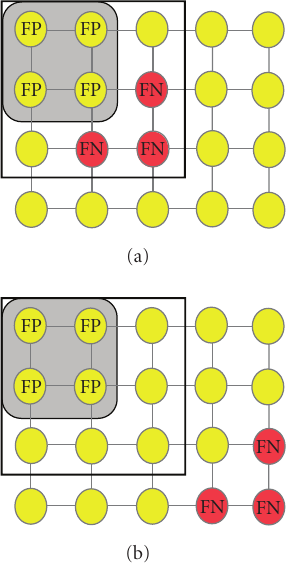
Figure 4: Schematic representation of an intracranial EEG grid placed on the surface of the brain. Electrophysiologically normal electrodes are yellow, whereas electrodes determined as abnormal (either onset, spread, or frequent spiking) are shown in red. The area with abnormal PET tracer concentration is depicted in grey. Electrodes overlaying the PET abnormality but which are found to be electrophysiologically normal represent false positive (FP) cases, whereas electrophysiologically abnormal electrodes not overlaying the PET abnormality represent false negative (FN) cases. (a) A PET abnormality in close spatial proximity to electrophysiologically ab- normal electrodes prompts the insertion of an intracranial grid (black square) which will include the electrophysiologically abnor- mal area, whereas (b) a PET abnormality that is distant to the elec- trophysiologically abnormal area will trigger the insertion of in- tracranial grid electrodes likely to miss the electrophysiologically abnormal